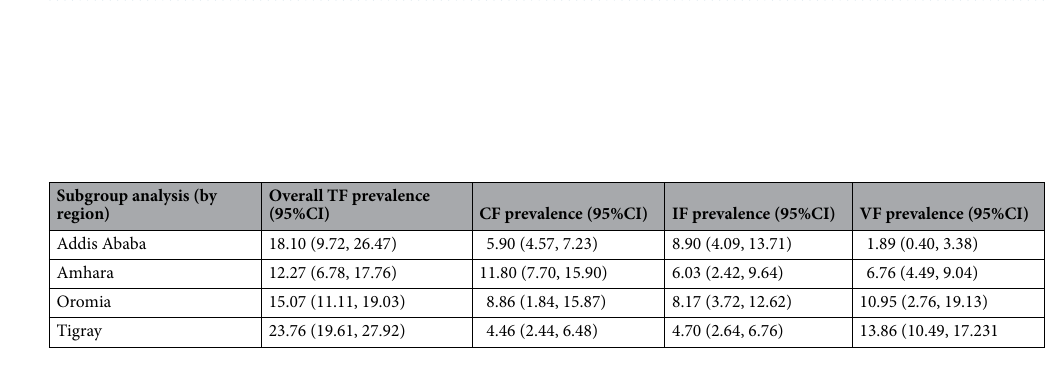
Table 2. Subgroup analysis by region showing the prevalence of clinical, immunological and VF among children in Ethiopia, 2020. CF clinical failure, IF immunological failure, VF virologic failure, TF treatment